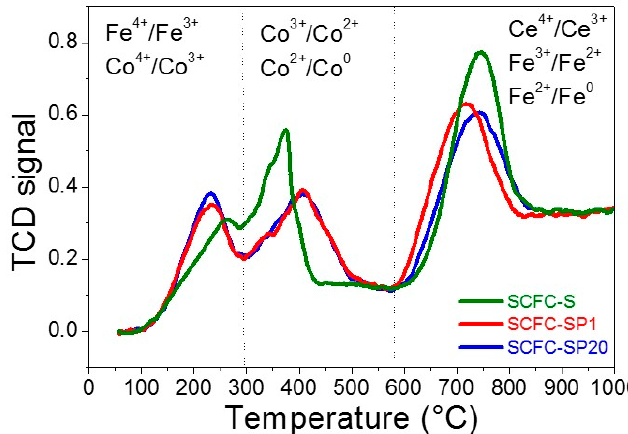
Figure 5. Temperature-programmed reduction experiment (TPR) results.